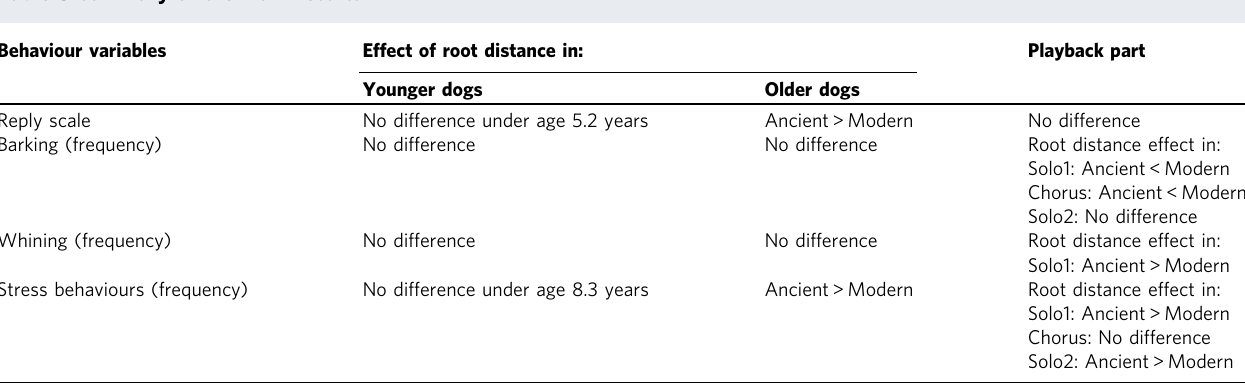
Table 3 Summary of the main